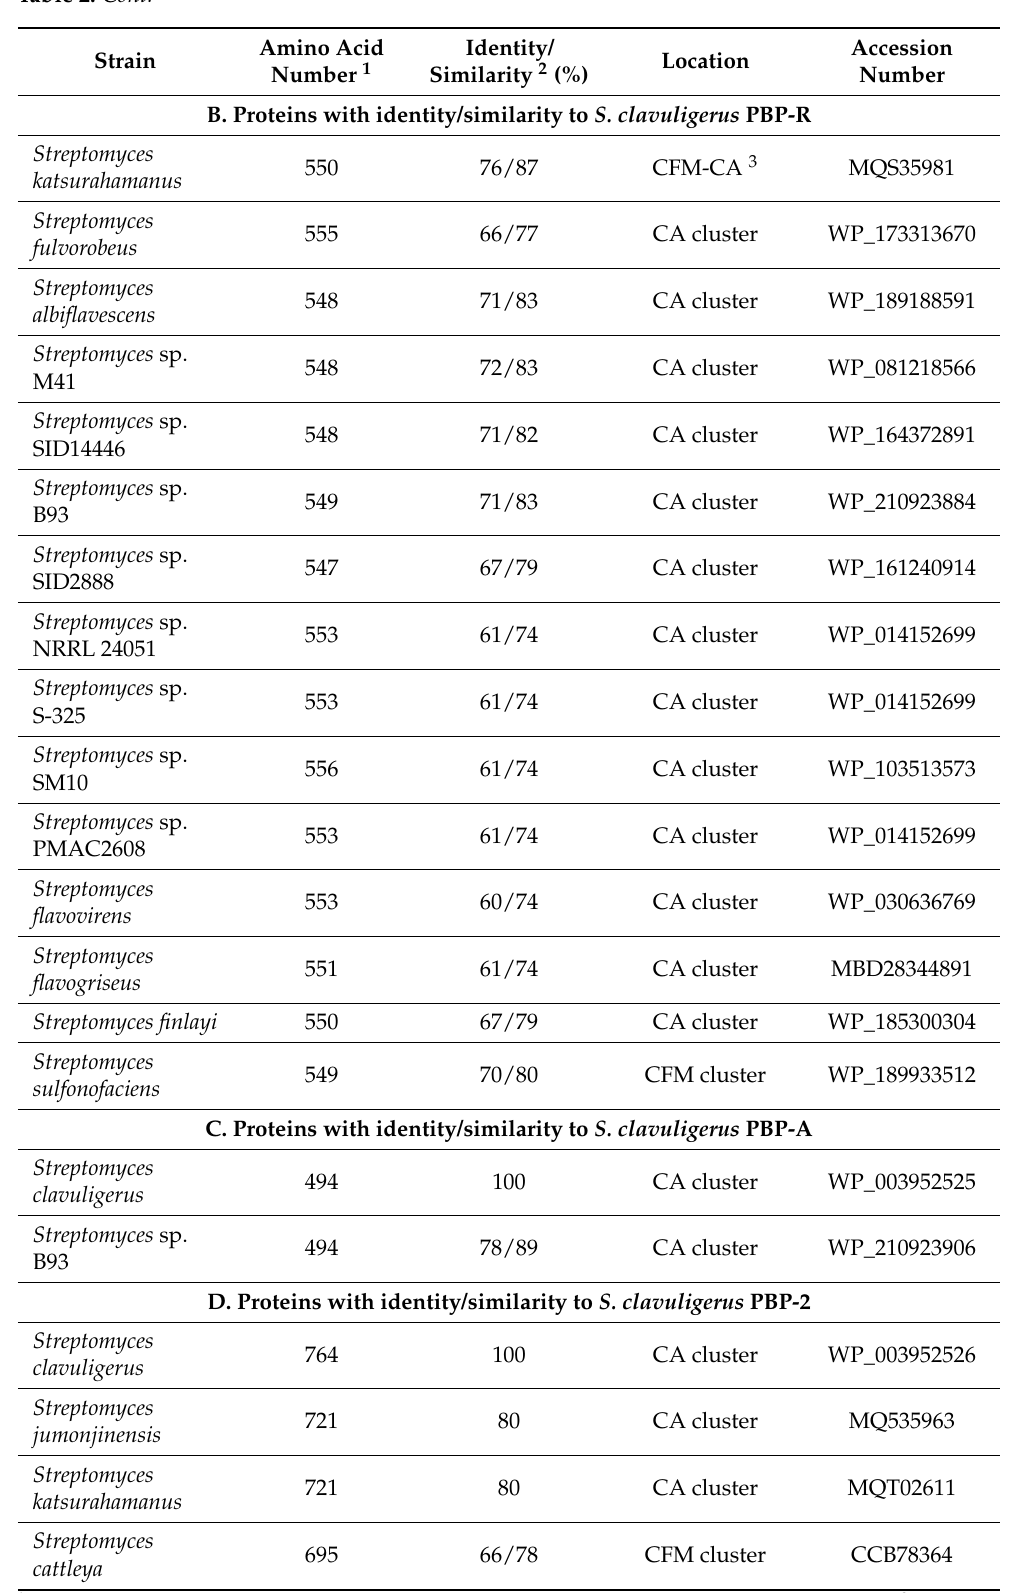
Table 2. Cont. Amino Acid Strain B. Proteins with identity/similarity to S. clavuligerus